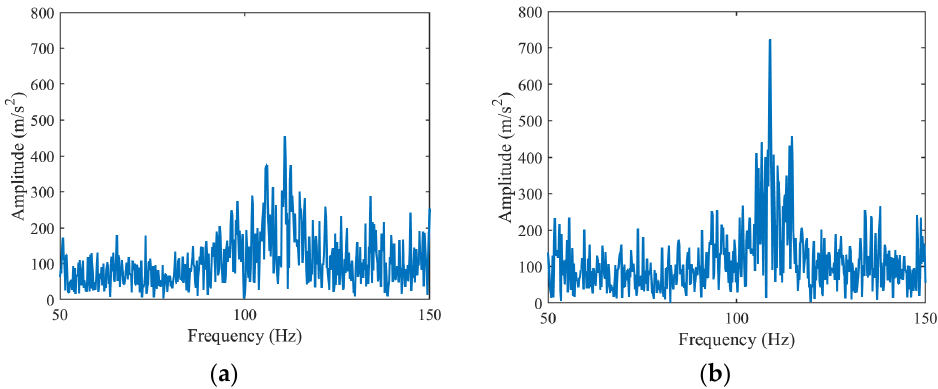
Figure 13. FFT spectrum of the vibration signal: ( a ) Before main bearing damage; ( b ) After main bearing damage.